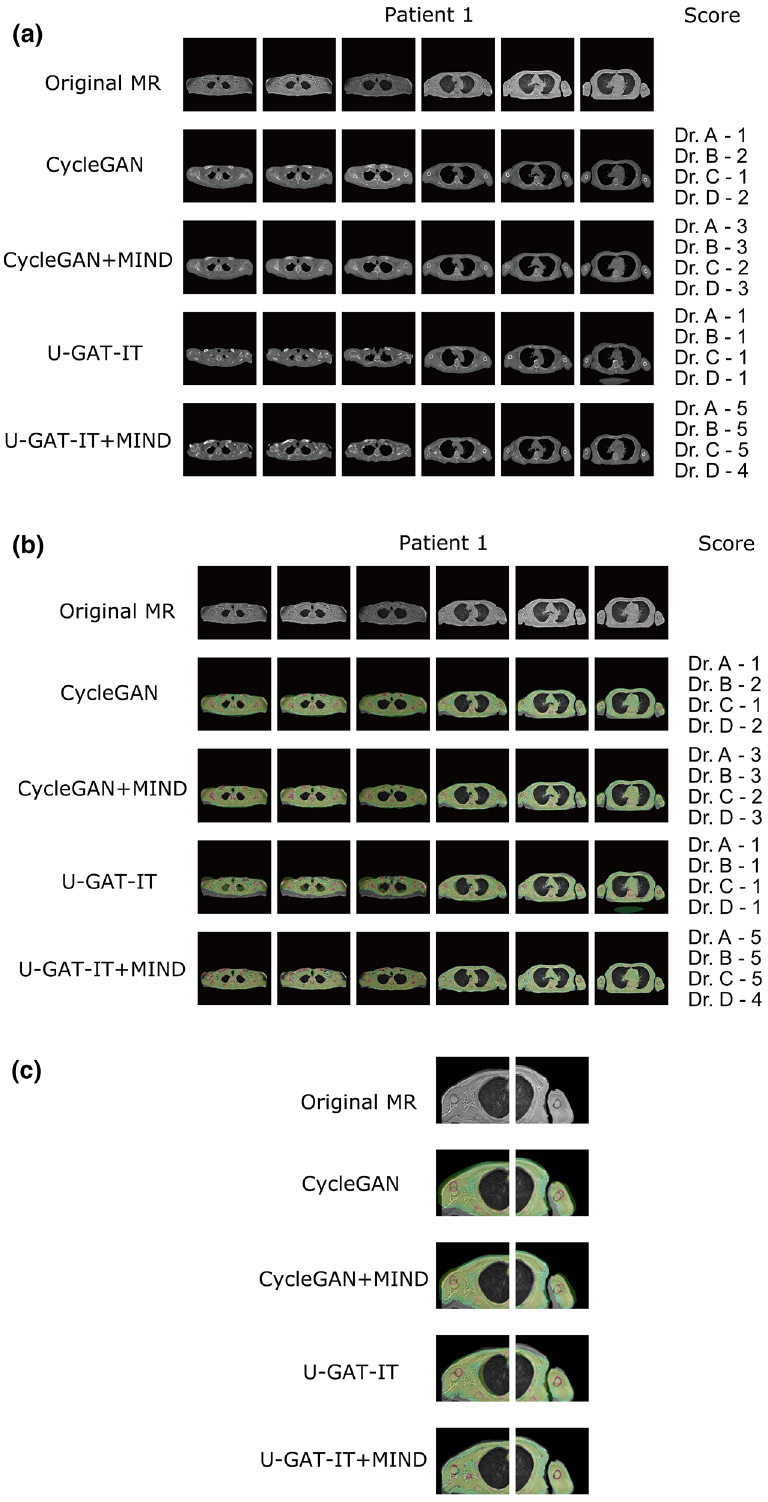
Figure 3. Original MR and synthesised CT images along with visual evaluation scores for Patient 1. ( a ) Original MR and synthesised CT images. ( b ) Original MR and fused images obtained from MR and synthesised CT. ( c ) Cropped images around the humerus in the original MR and fused images obtained from MR and synthesised